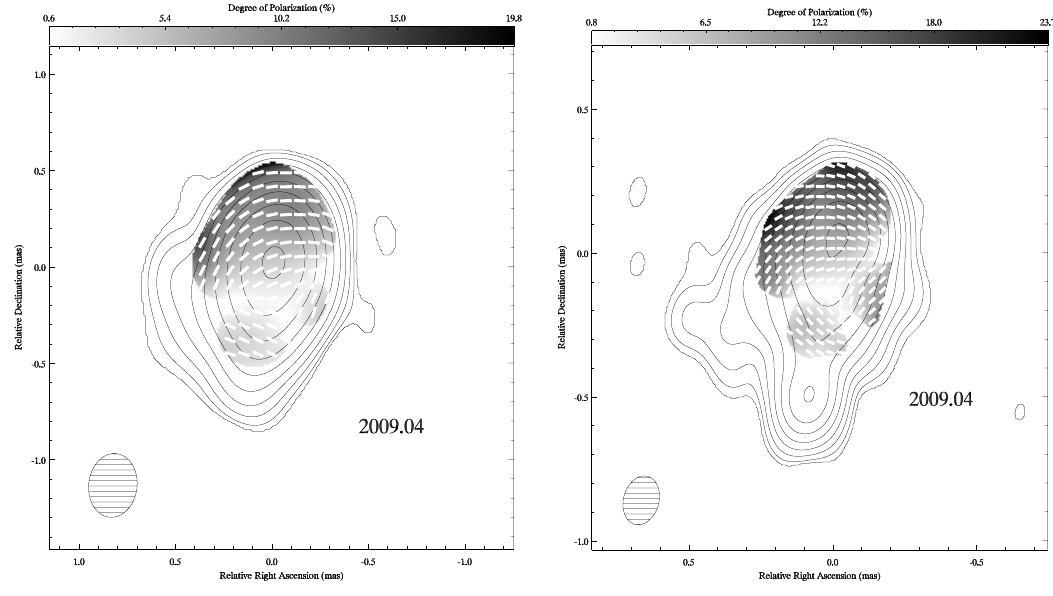
Figure 4. Linear polarization degree of NRAO 150 as measured with the VLBA at 22 and 43 GHz ( left and right , respectively) superposed with the distribution of the magnetic vector position angle during